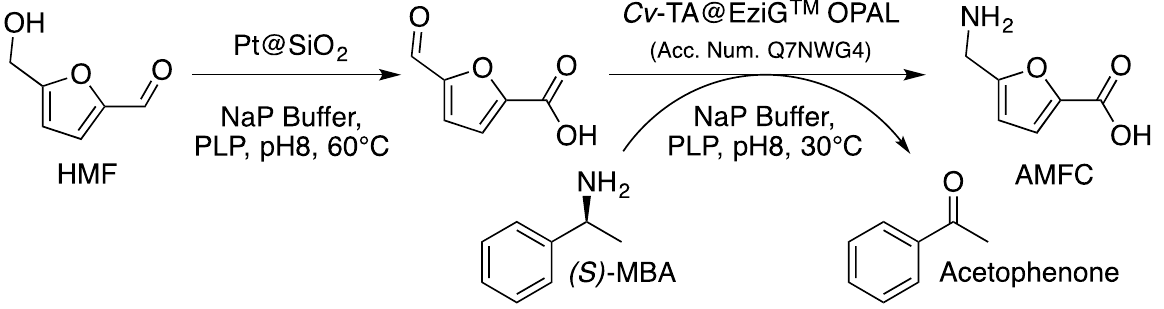
Figure 18. One-pot/two-step hybrid heterogeneous catalytic process for the conversion of HMF into AMFC, combining a Pt/SiO 2 chemocatalyst and the Cv-TA. Adapted with permission from Ref. [117]. By using a one-pot/two-step process, in which the enzyme was added directly to the reaction medium after the catalyst has completed its reaction and the temperature has dropped to around 30 ◦ C, a 77% yield of FMCA can be achieved. It is noteworthy that the reaction medium was found to be compatible with both catalysts after its